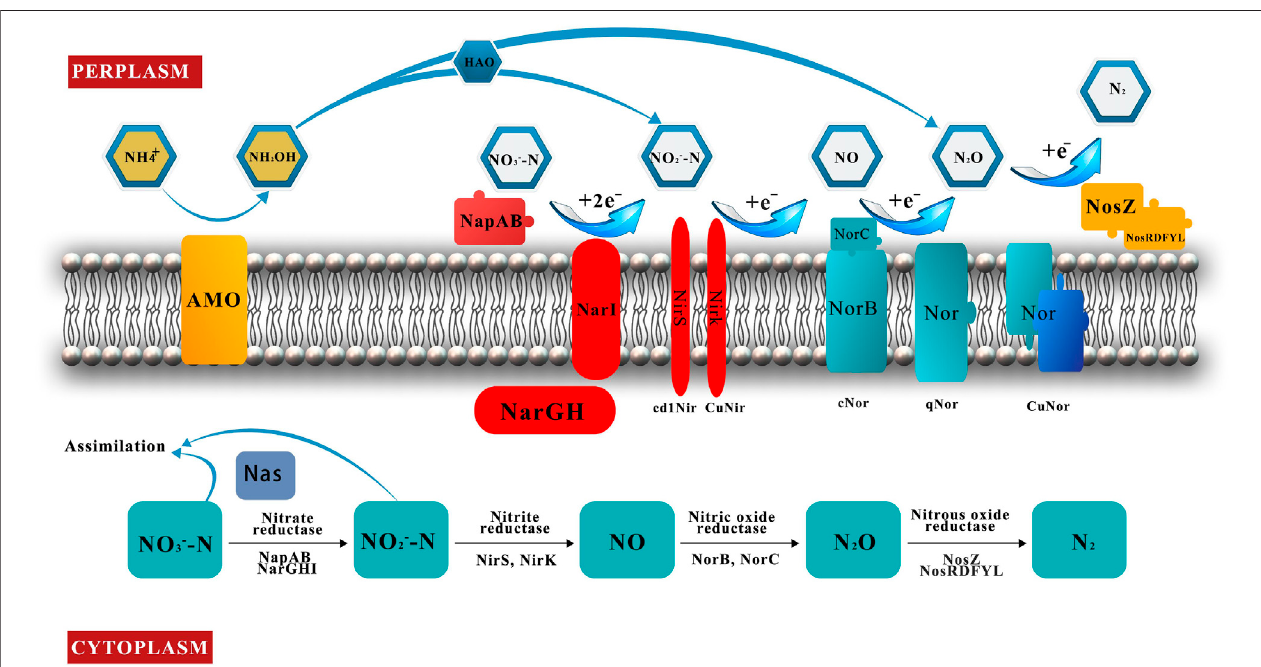
FIGURE 3 | Schematic of nitri fi cation, denitri fi cation, and assimilation reactions under aerobic conditions.